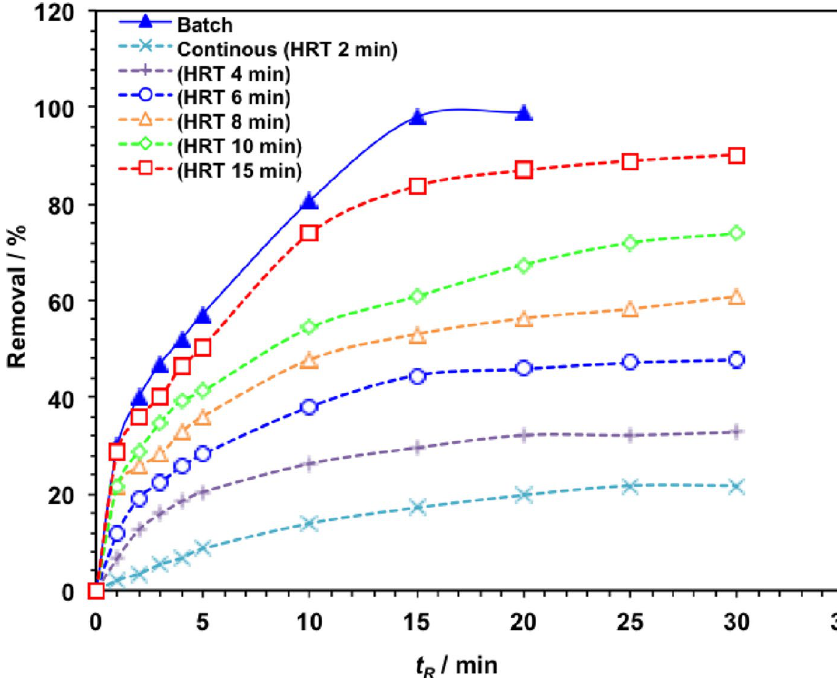
Fig. 8 Synozol Blue dye oxidation with the reac- tion time for the continuous Mn 0.6 Zn 0.4 Fe 2 O 4 /H 2 O 2 /UV sys- tem (Catalyst 40 mg L 1 , H 2 O 2 400 mg L −1 , pH